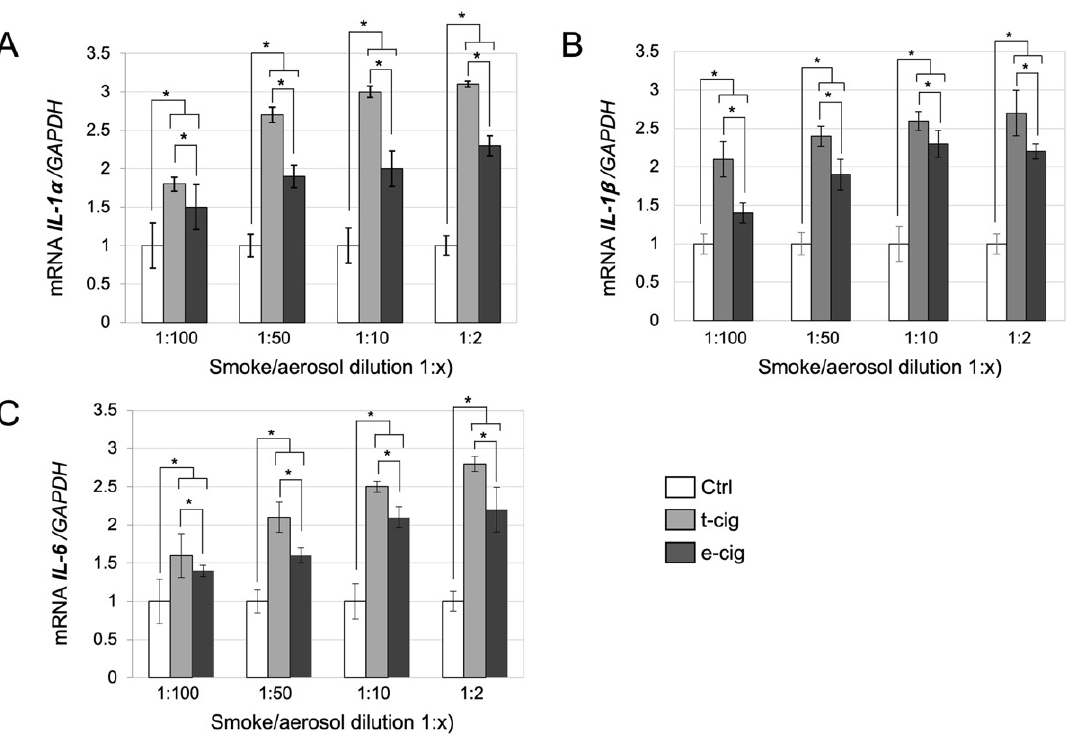
Figure 5. Inflammatory cytokine gene expression by HEGK exposed to the negative control and four increased dilutions of aerosol/smoke from the e-cig and t-cig (1:2, 1:10, 1:50, 1:100). ( A ) IL-1 α , ( B ) IL-1 β , ( C ) IL-6. Means ± SD, * p < 0.05.